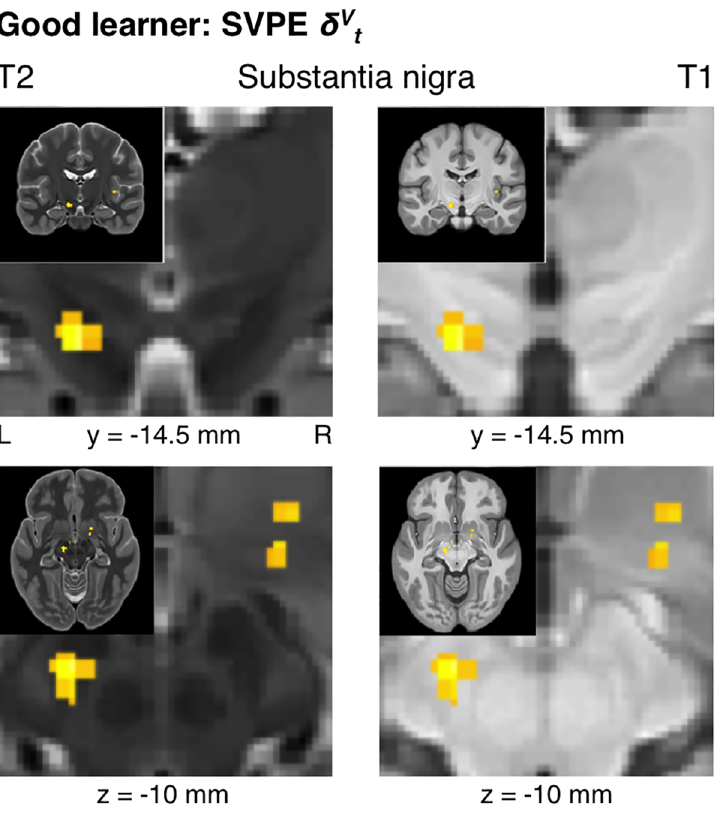
Fig 5. Good-learner group: State-value-prediction-error signals in the dopaminergic midbrain. Focusingon the dopaminergic midbrain,SVPE signalswere found withinthe substantia nigrafor the Good- learnergroup ( p < 0.005 unc., SVC p FWE < 0.05). To better visualizethe anatomyof the dopaminergic midbrain,the same statistical map is plotted over T2-weighted and T1-weighted structural imagesin the left and right panels, respectively. Also visibleis the ventral tegmental area (high intensity for T2, low intensity for T1), correspondingto a regionbetween the dorsal edgeof the substantianigra (low intensity for T2, heterogeneous intensity for T1) and the ventraledgeof the red nucleus(low intensity for T2, high intensity for T1). Coronalsectionsare displayedin the upperpanels, andaxial sections are displayed in the lower panels.